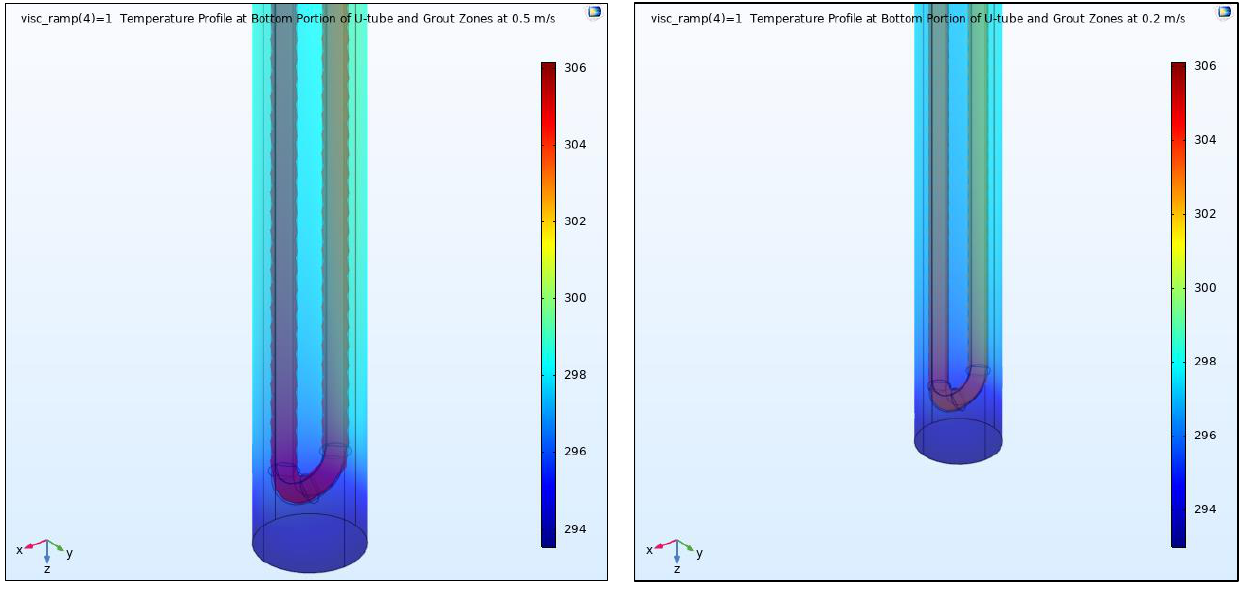
Figure 9.a. Water velocity of (0.5) m/s Figure 9.b. Water velocity of (0.2) m/s Figure 9. Temperature distribution at the single U-tube and grout for various flow